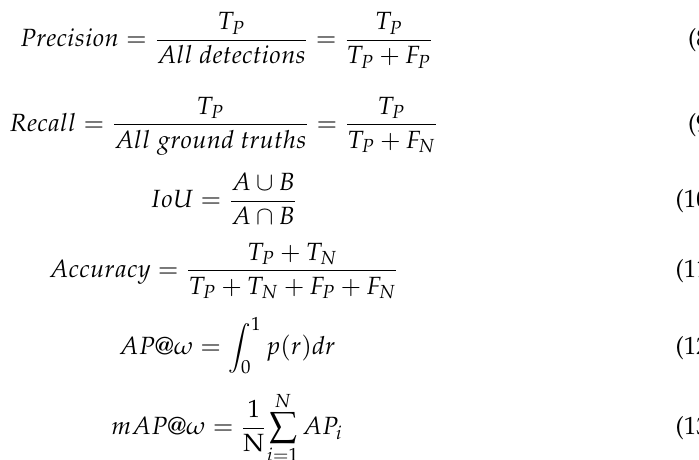
Figure 5. Sample images from potholes dataset.